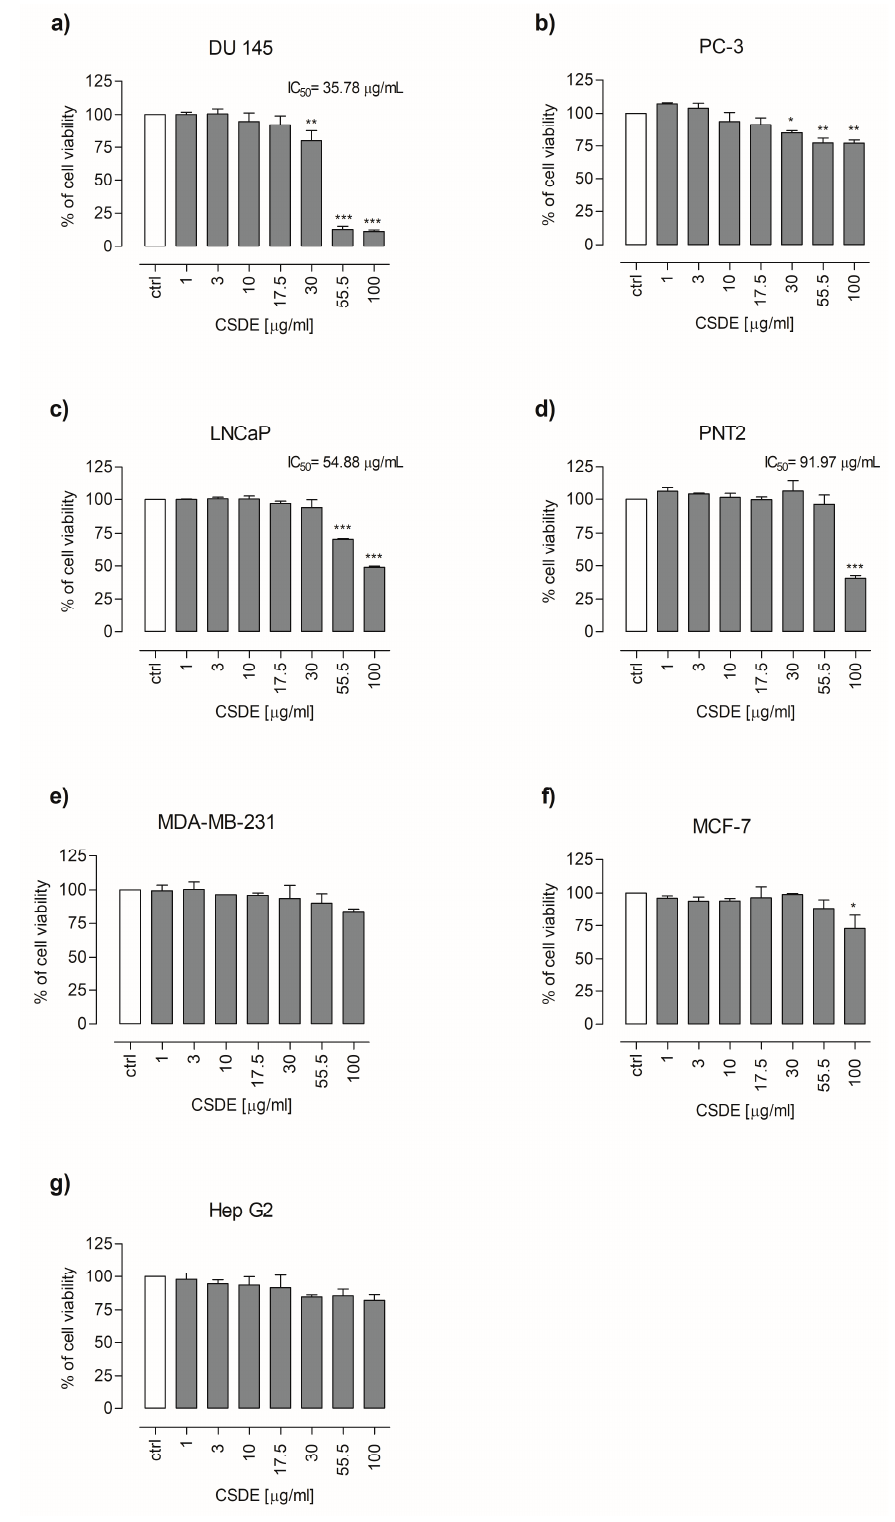
Figure 1. Cytotoxic e ff ects of chestnut shells dry extract (CSDE, 1–100 µ g / mL, 24 h exposure) in DU 145 ( a ), PC-3 ( b ), LNCaP ( c ), PNT2 ( d ), MDA-MB-231 ( e ), MCF-7 ( f ), and Hep G2 ( g ) cells. Viability (expressed as percentage of cell viability) rate was investigated by using the MTT assay. Each bar represents the mean ± SD of three independent experiments. * p < 0.05, ** p < 0.01, and *** p < 0.001 vs. control (untreated cells).